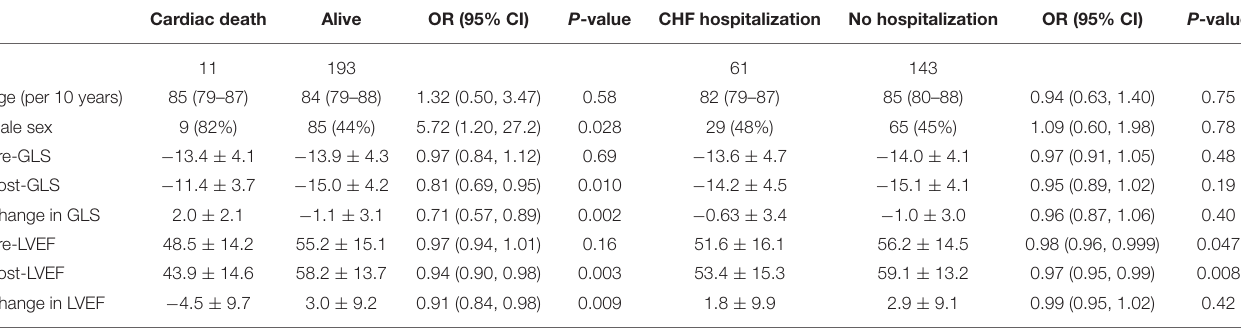
TABLE 3 | Baseline characteristics for TAVR patients who were alive vs. those who died of cardiac causes at 1 year and those hospitalized for CHF vs. those with no CHF hospitalization at 1